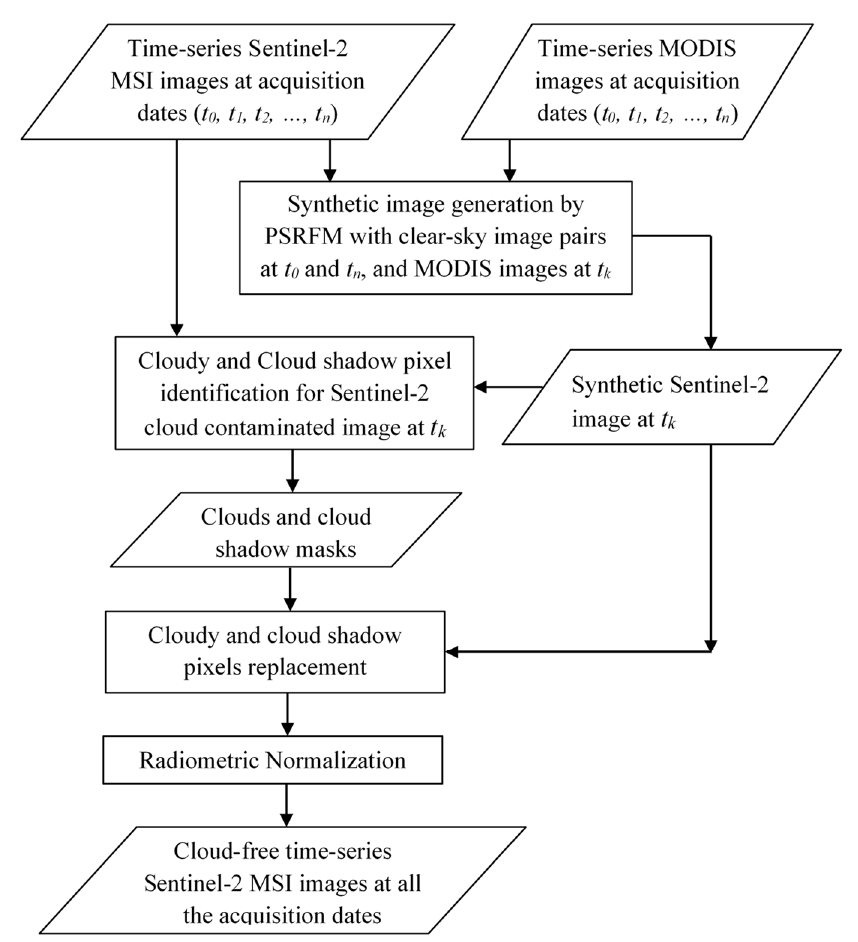
Figure 1. Reconstruction process flowchart. Date t k indicates all acquisition dates when clear-sky images were not available.